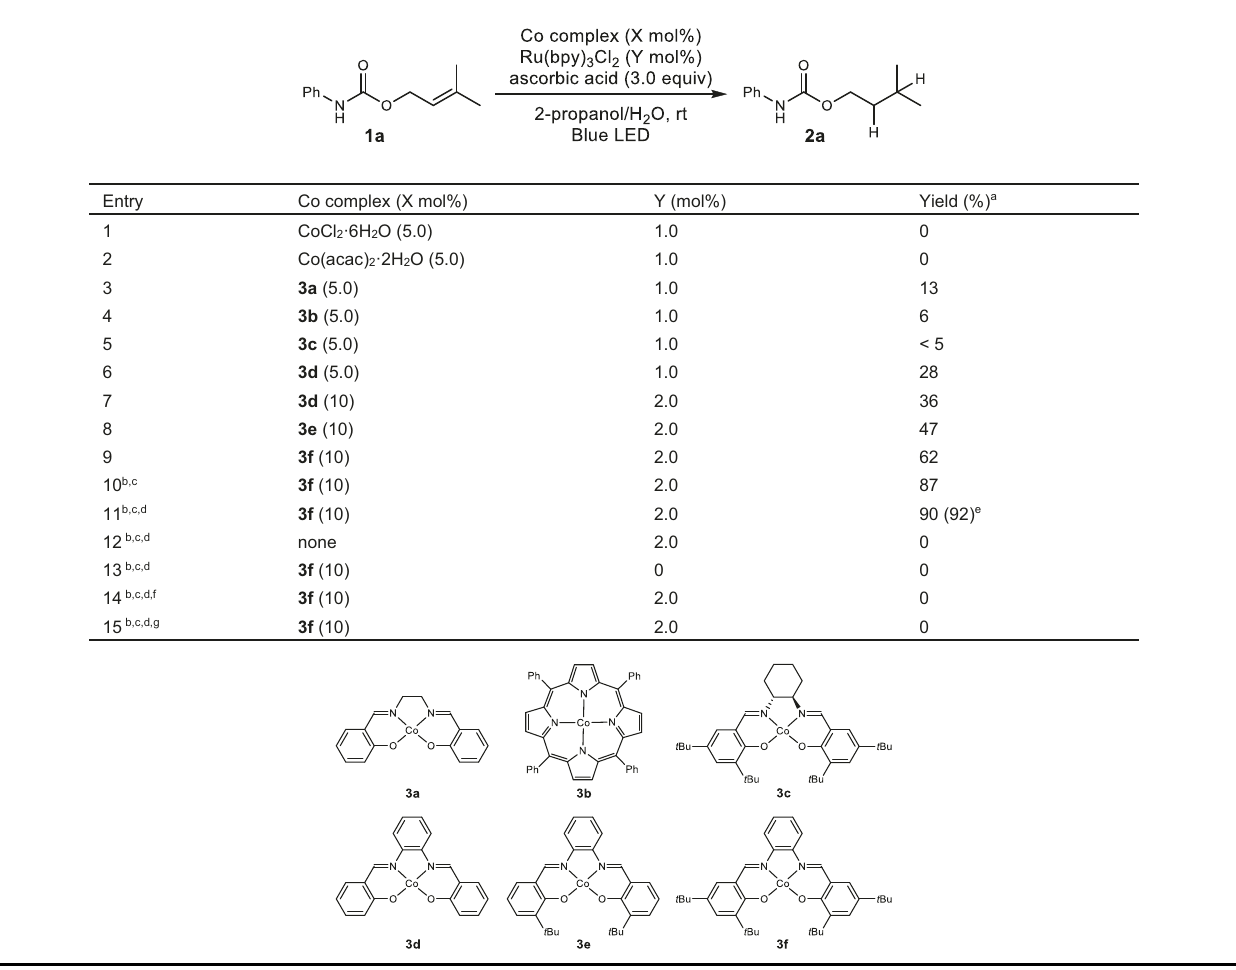
Table 1 Evaluation of the reaction conditions for the combined cobalt/photoredox-catalyzed hydrogenation of